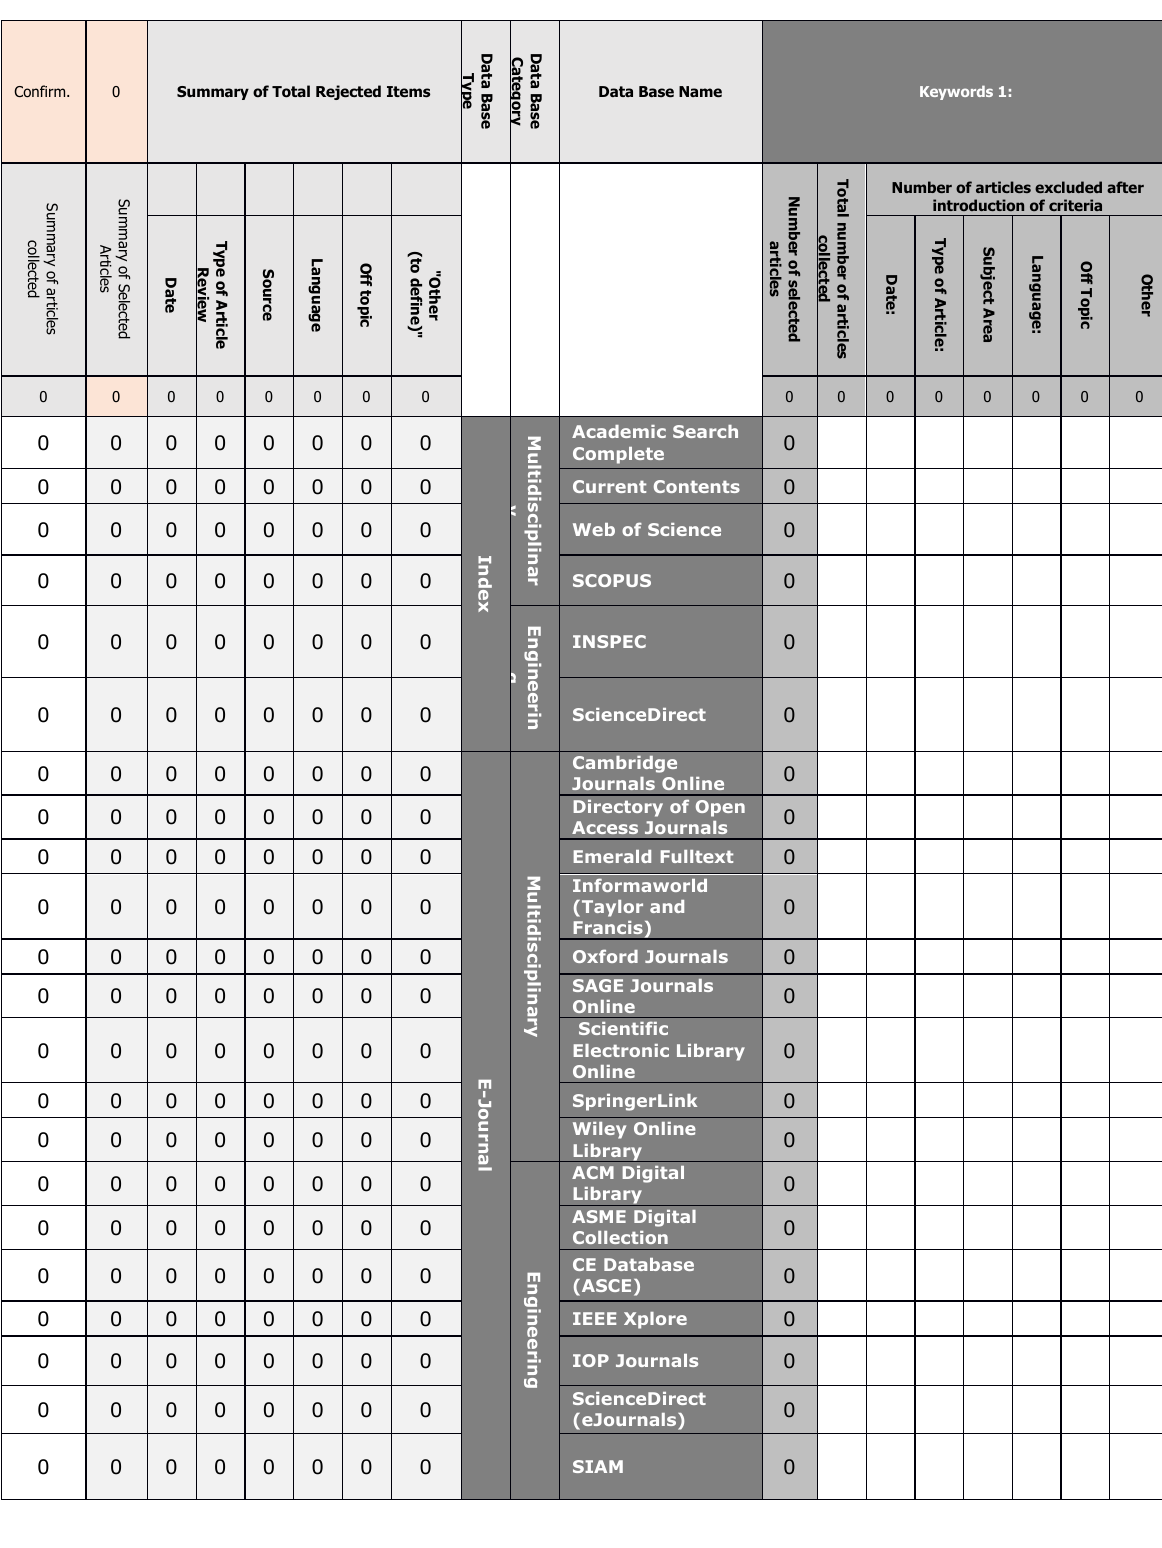
Table 1 for data records